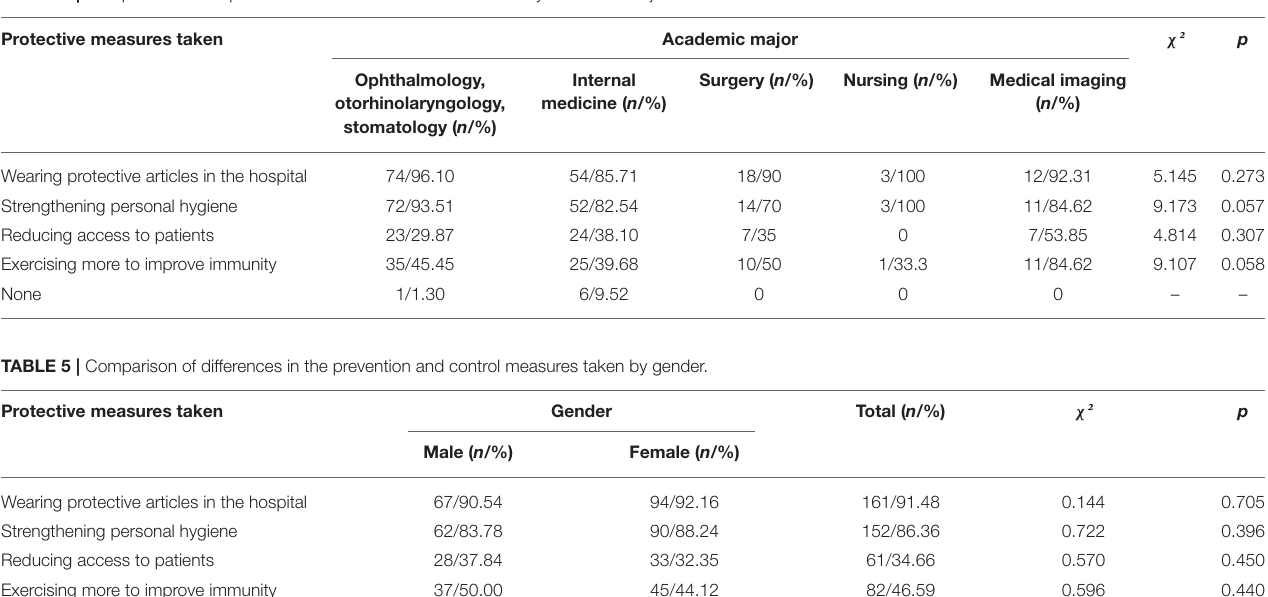
Wearing protective articles in the